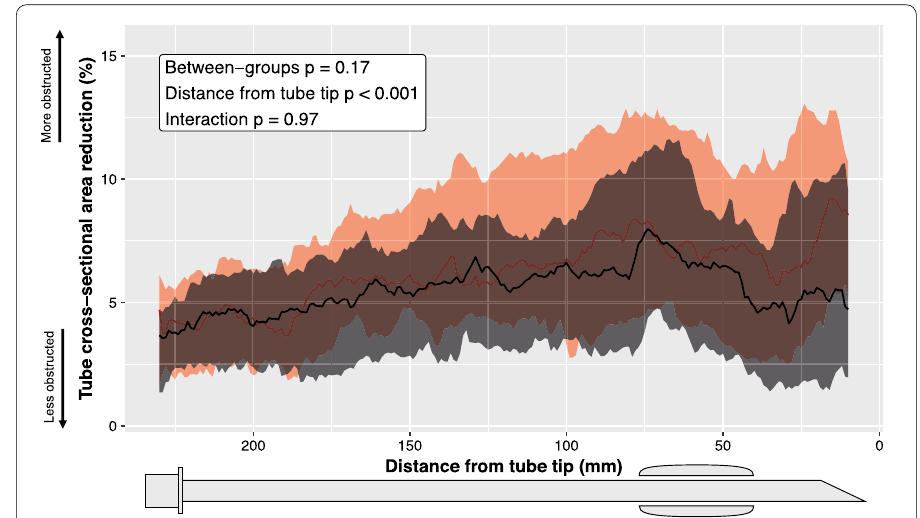
Fig. 3 Endotracheal tube percent cross-sectional area reduction of each 1-mm section as function of the distance from the tube tip in patients receiving on-demand nebulizations (black) and patients receiving routine nebulizations (red). Values are plotted as median; error bands represent interquartile ranges. This plot represents the average mucus distribution in the two randomization arms, which is lower compared to the maximum cross-sectional area reduction of each patient. P -values are calculated with a two-way ANOVA using the distance from the tube tip and the randomization arm as factors. mm, millimeter